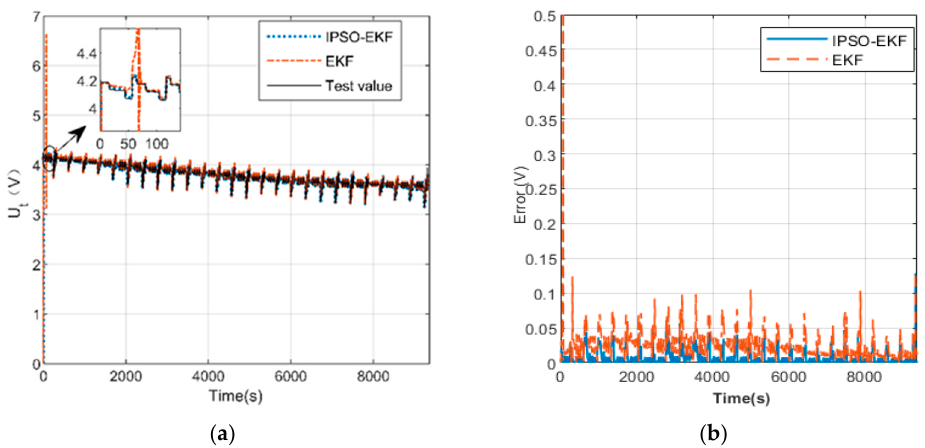
Figure 4. Terminal voltage comparison: ( a ) terminal voltage change value and ( b ) terminal voltage error.